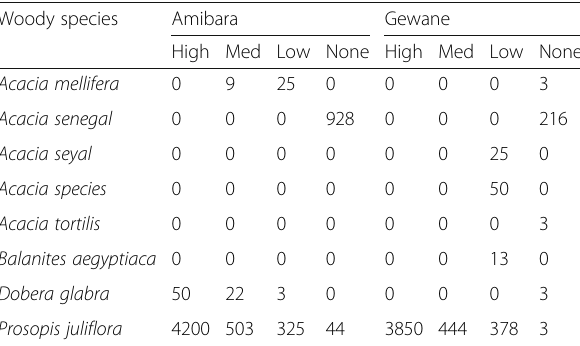
Table 1 Density of observed woody species at different levels of P. juliflora invasion